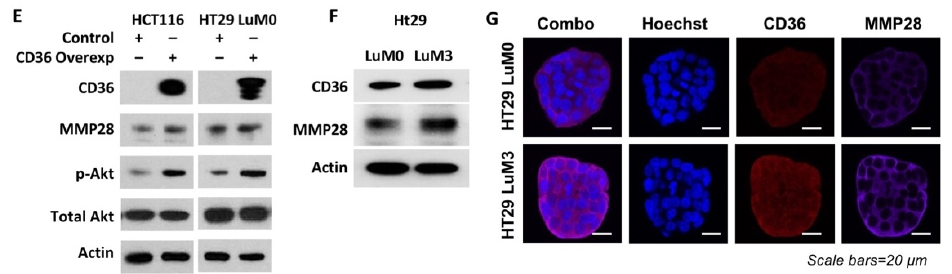
Figure 4. CD36 regulates expression of MMP28 . ( A ) Representative gene set enrichment analysis (GSEA) plots generated from RNA ‐ Seq expression data of the HT29 p ‐ Lenti Control and HT29 p ‐ Lenti CD36 overexpression cell lines. The top 10 enriched pathway sets are provided in Figure S2. Bar codes indicate the location of gene set members in the ranked list of all genes. ES, enrichment score; NES, normalized enrichment score; NOM, nominal p ‐ value; FDR, false discovery adjusted p ‐ value. ( B ) Volcano plot of the HT29 p ‐ Lenti Control and HT29 p ‐ Lenti CD36 overexpression cell lines, showing increased levels of CD36 mRNA associated with an increase in MMP28 mRNA expression. ( C ) qRT ‐ PCR analysis of CD36 and MMP28 mRNA in the HT29, p ‐ Lenti Control and p ‐ Lenti CD36 overexpression cell lines, and in the HT29 LuM3 GFP ‐ Luciferase NTC and shCD36 cell lines. ( D ) qRT ‐ PCR analysis of CD36 and MMP28 mRNA in the HCT116, p ‐ Lenti Control and p ‐ Lenti CD36 overexpression, and HCT116 NTC and CD36 shRNA cell lines. ( E ) Western blot analysis of the HCT116 and HT29 LuM0 p ‐ Lenti Control and p ‐ Lenti CD36 overexpression cell lines for CD36, MMP28, p ‐ Akt and total Akt. ( F ) Western blot analysis of CD36 and MMP28 in HT29 LuM0 and HT29 LuM3 GFP ‐ Luciferase cell lines. ( G ) Confocal microscopy of the HT29 LuM0 and HT29 LuM3 GFP ‐ Luciferase cell lines for actin, CD36 and MMP28. * p < 0.05, ** p < 0.01, *** p < 0.001; SEM.